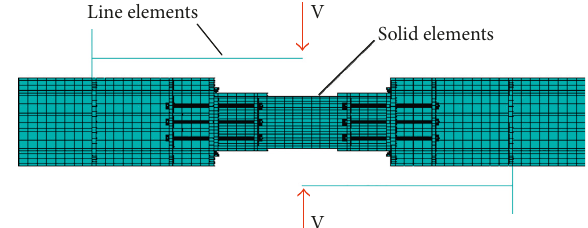
Figure 17: FE model of self-centering steel link